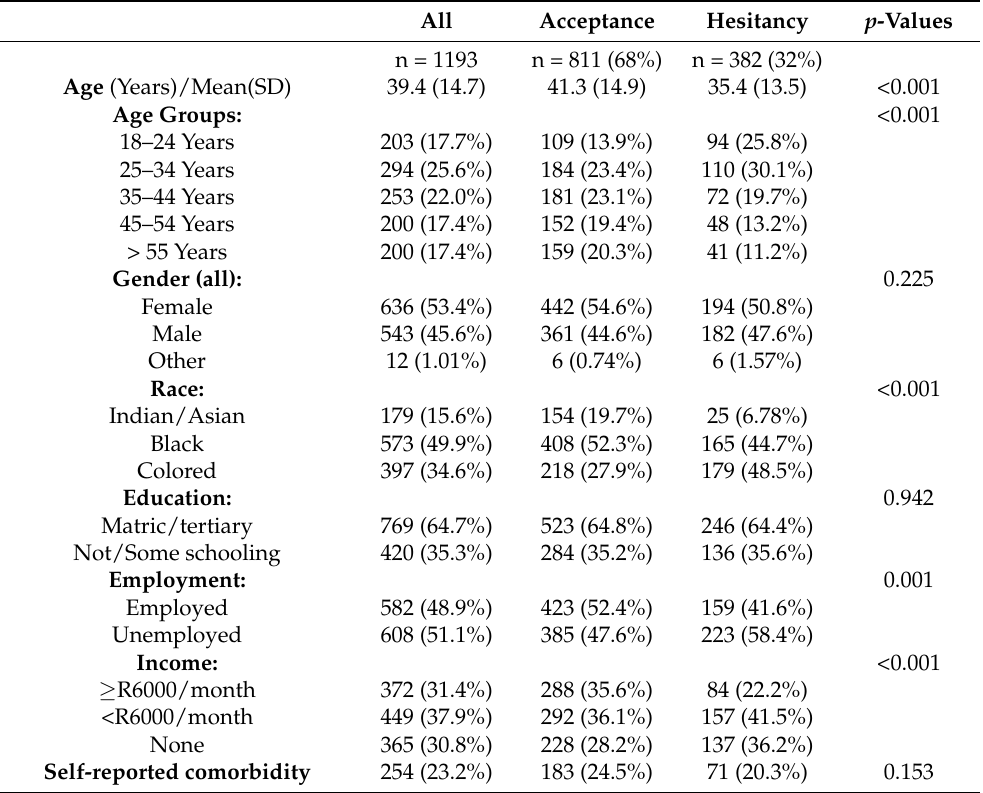
Table 1. Sociodemographic characteristics of 1193 South Africans included in the VaxScenes Study from the 6 June to the 30 July